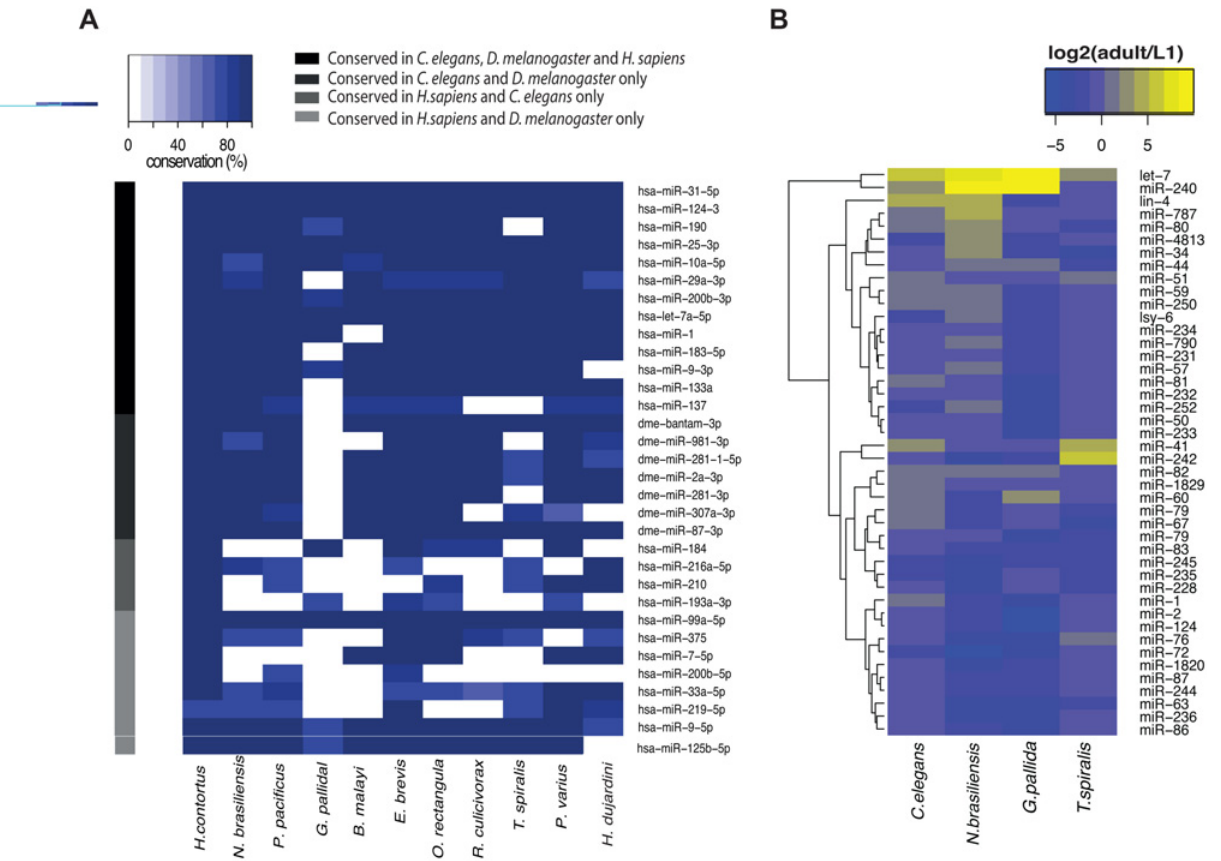
Fig 2. miRNA families and expression in the phylum Nematoda. (A) Conservation of conserved miRNA families, grouped by seed in nematodes. The family is named after the most abundant H . sapiens family member, or the human member if no H . sapiens member exists. The colour bar indicates conservation of a miRNA in C . elegans , D . melanogaster , H . sapiens or a combination thereof. (B) The developmental profile of miRNAs is conserved across Nematoda. All C . elegans miRNAs present in all of the species profiled are